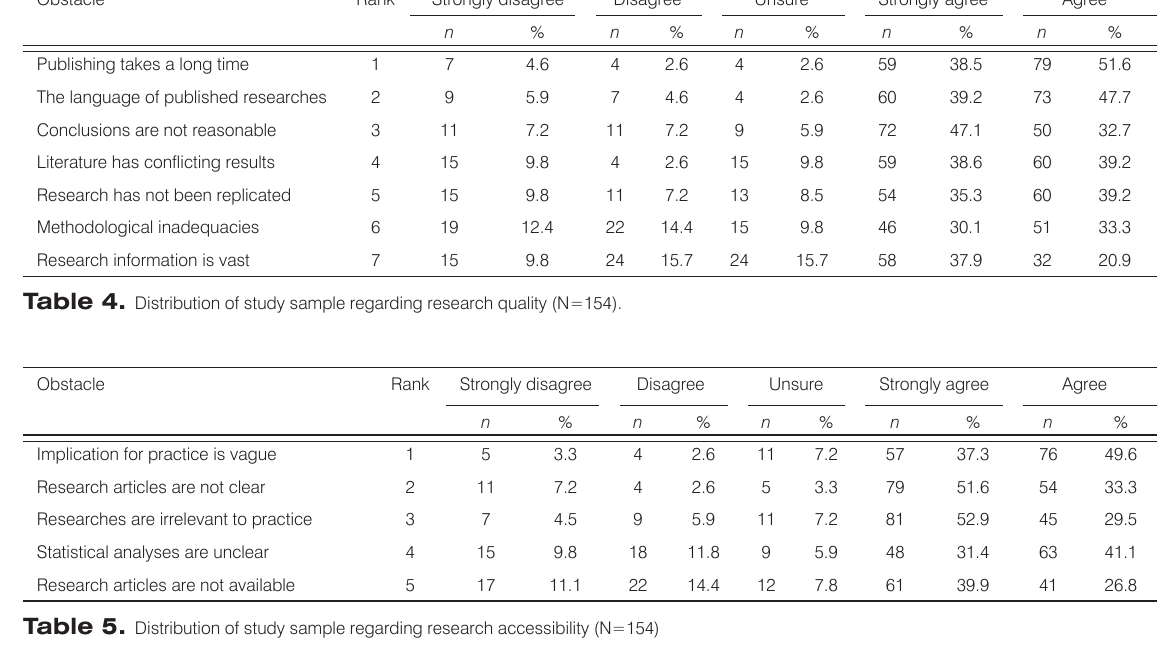
Table 5. Distribution of study sample regarding research accessibility (N=154)